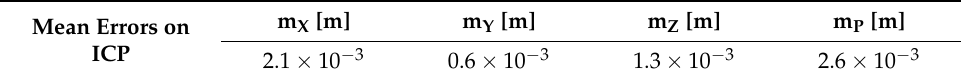
Table 11. Mean error (standard deviation) for one of field surveying data set.